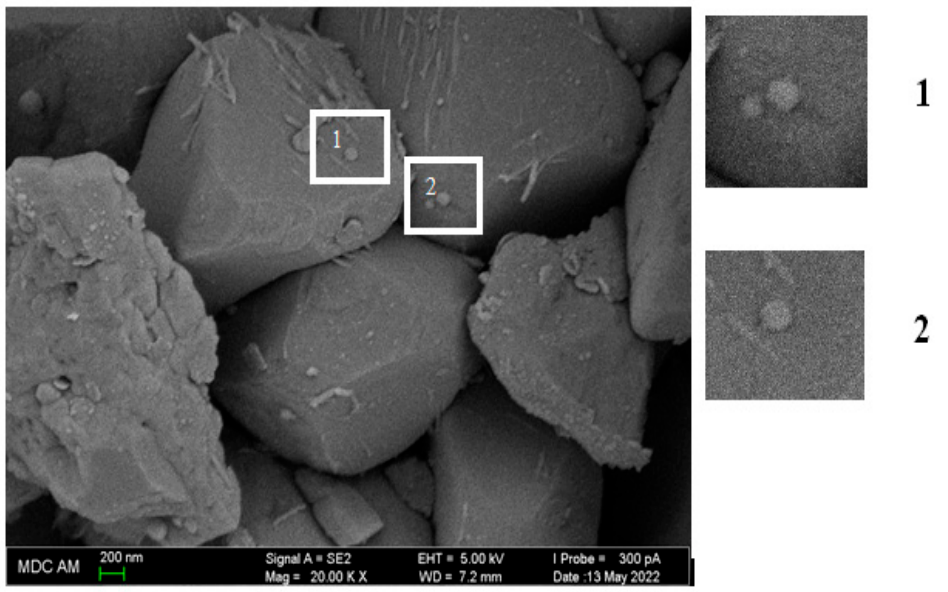
Figure 15. SEM images of catalyst particles on the rock.